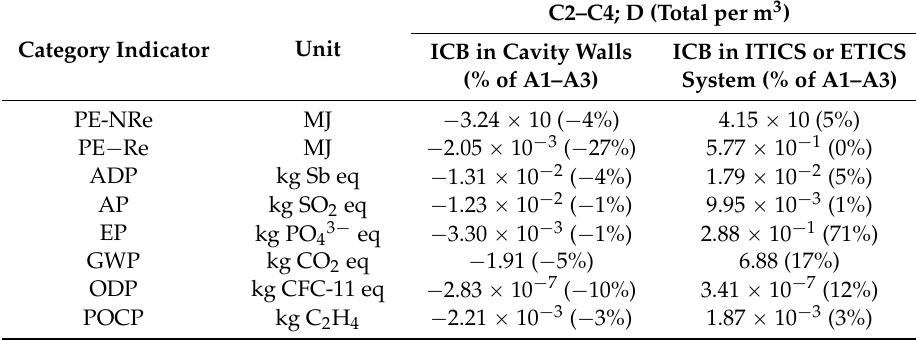
Table 5. LCA results for the End-of-life stage (C2–C4) and for Benefits and loads beyond the system boundary (D) of one cubic metre of ICB (with a density of 110 kg/m 3 ), and comparison with A1–A3 (Table